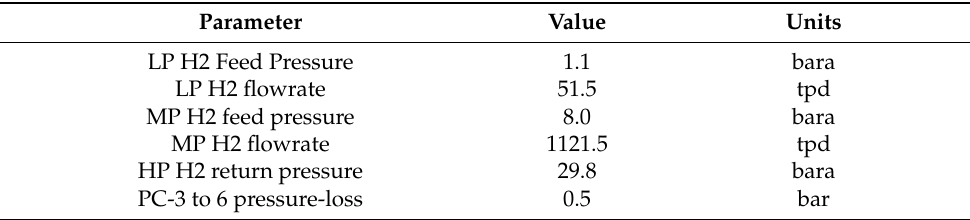
Table 2. Summary of fixed modelling parameters for the cryogenic-cooling cycle compressor.